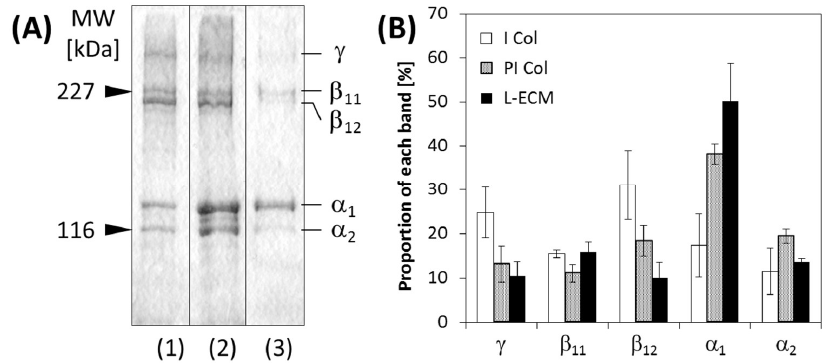
Figure 4. I ( A ) SDS-PAGE of each sample. (1) Solubilization with acid (I Col), (2) pepsin-acid solubilization (PI Col), and (3) L-ECM. The concentration of each solution was 0.75 mg/mL. ( B ) Ratios of detected bands in the all components ( n = 3, bars represent standard deviation.).